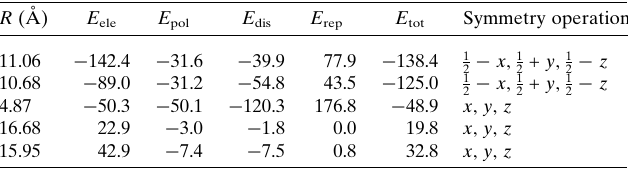
Table 3 Summary of interaction energies (kJ mol (cid:4) 1 ) calculated for (I). R (A˚ )